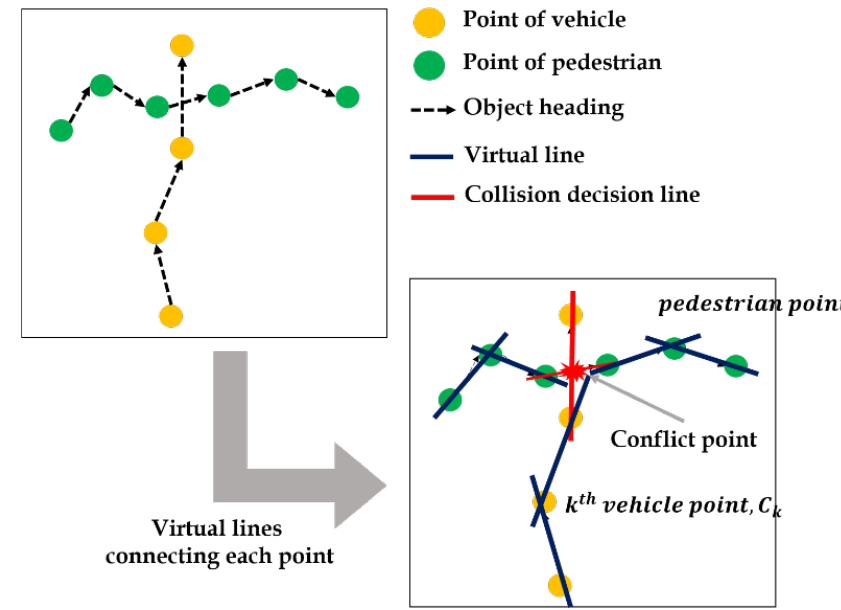
Figure 9. Expected conflict point in object trajectories.